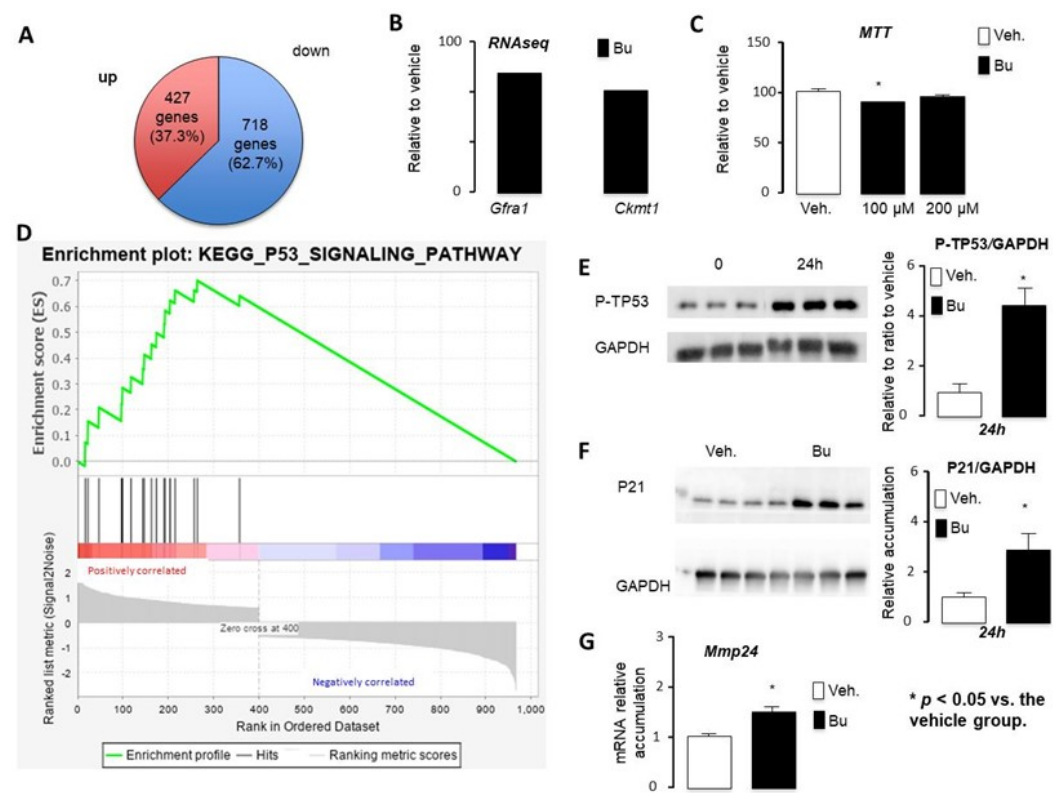
Figure 5. The RNAseq approach defined key targets of busulfan in the GC1spg cell line. ( A ) Venn diagram for differentially expressed genes in GC1spg cells tr eated for 24 h with vehicle or 200 µ M Bu. ( B ) Fold change of Gfra1 and Ckmt1 obtained from the RNAseq data. ( C ) MTT data for the GC1spg cells treated for 24 h with vehicle or 100 µ M or 200 µ M Bu. ( D ) GSEA data obtained for genes differentially expressed in Bu- vs. vehicle-treated GC1spg cells. ( E ) Representative Western blots of GAPDH and Phospho-TP53 (P-TP53) and quantification of ratios in GC1spg cells treated with vehicle or Bu for 24 h. ( F ) Representative Western blots of GAPDH and P21 and quantification of ratios in GC1spg cells treated with vehicle or Bu for 24 h. ( G ) Relative Mmp24 mRNA accumulation normalized to β -actin on GC1spg cells treated for 24 h with vehicle or 200 µ M of Bu. Veh.: vehicle and Bu: busulfan. * p < 0.05, vs. the vehicle group.